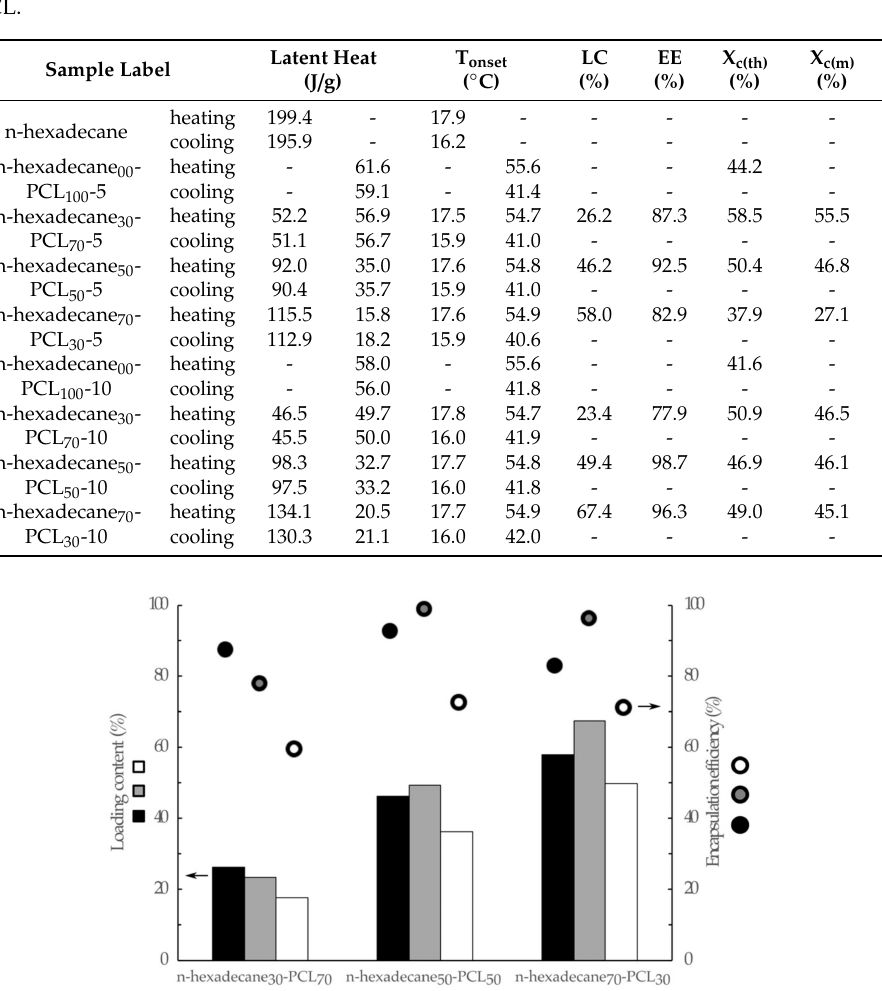
Figure 4. Influence of the nozzle system and the concentration of the PCL solution on the loading content and encapsulation e ffi ciency (black—coaxial nozzle—5 w / v % PCL; grey—coaxial nozzle— 10 w / v % PCL; white—single nozzle—10 w / v %